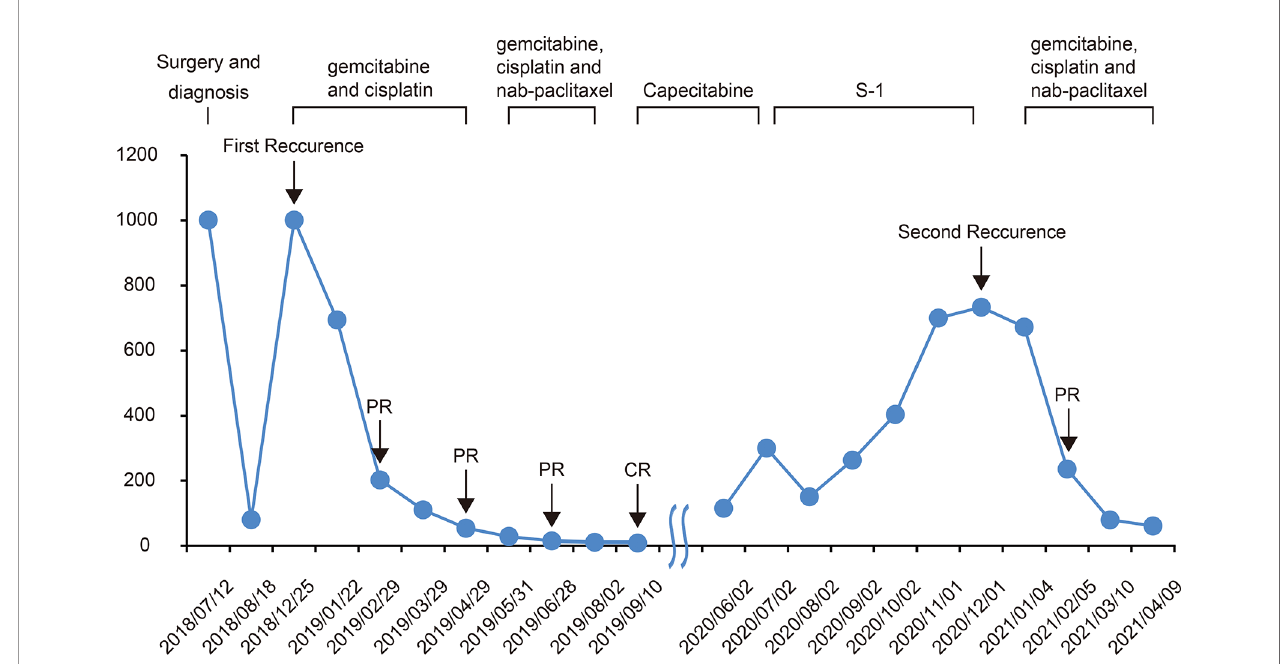
FIGURE 2 | Changes in CA199 levels during the treatment and follow-up. The CA199 tumormarker was measured inpatients ’ blood at periodic intervalsthroughout the clinical course and annotated with date, therapeuticapproach, andtreatment ef fi cacy.CA199, cancer antigen 199; CR complete response; PR partial